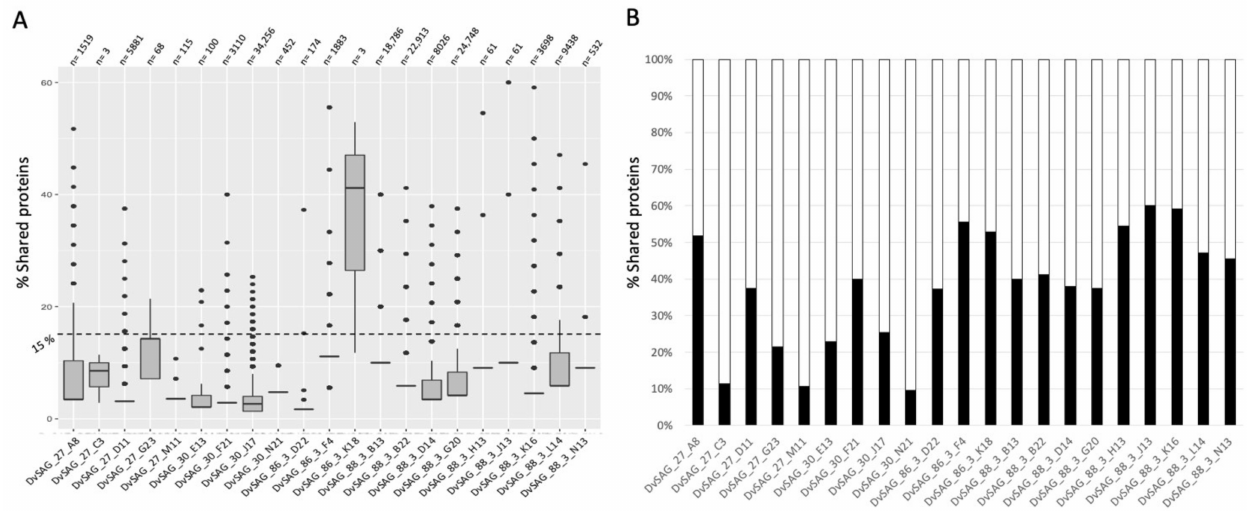
Figure 2. Novel deep-ocean viruses obtained from single-virus genomics. ( A ) Percentage of shared proteins (amino acid similarity >80% and query coverage >90%) between vSAGs and viruses from IMG/VR v3.0 database. “n” represents the number of known viruses sharing at least one protein with the corresponding vSAG. ( B ) Percentage of shared proteins for each vSAG versus its closest viral relative found in the IMG/VR v3.0 database. Detailed data about each comparison (e.g., number of proteins, similarity, coverage, and Scaffold ID for each similar virus found in the IMG/VR v3.0) can be found in the Supplementary Table